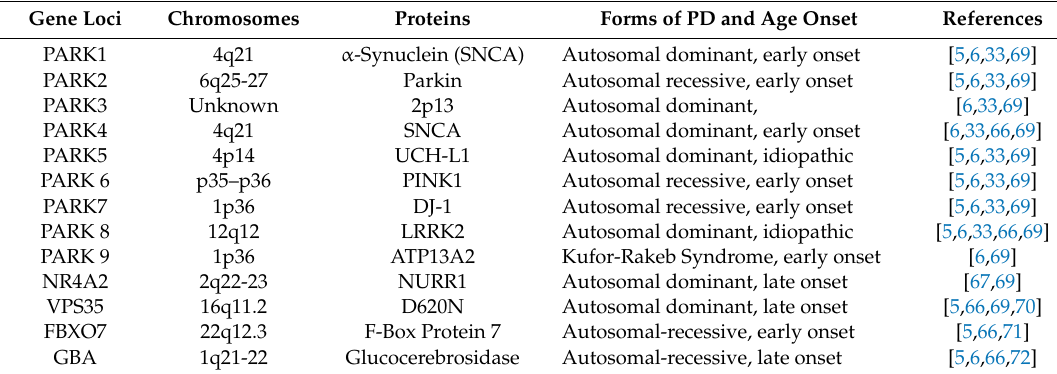
Table 1. Genes associated with Parkinson’s